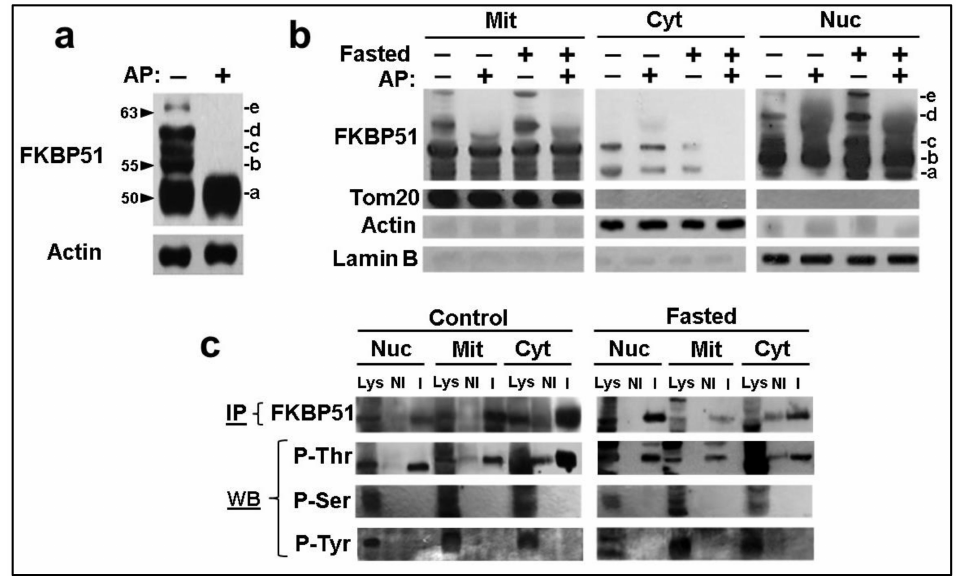
Figure 2. FKBP51 is a phosphoprotein. ( a ) FKBP51 isoforms were resolved in a 15%PAGE/SDS followed by Western blot after incubation of mouse liver extracts for 40 min at 30 ◦ C without ( − ) and with (+) alkaline phosphatase (AP). The FKBP51 isoforms are labeled with letters (a–e). ( b ) FKBP51 isoforms (a–e) were resolved in mitochondria (Mit), cytosol (Cyt), and nuclei (Nuc) after biochemical fractionation. Tom20 was used as a mitochondrial marker, actin as a cytoplasmic marker, and lamin B as a nuclear marker. ( c ) After biochemical fractionation of control and fasted mouse livers, FKBP51 was immunoprecipitated (IP) and Western blotted (WB) with the indicated anti-phospho-amino acid antibodies. Lys = Whole lysate. NI = Non-immune IgG. I = IgG against